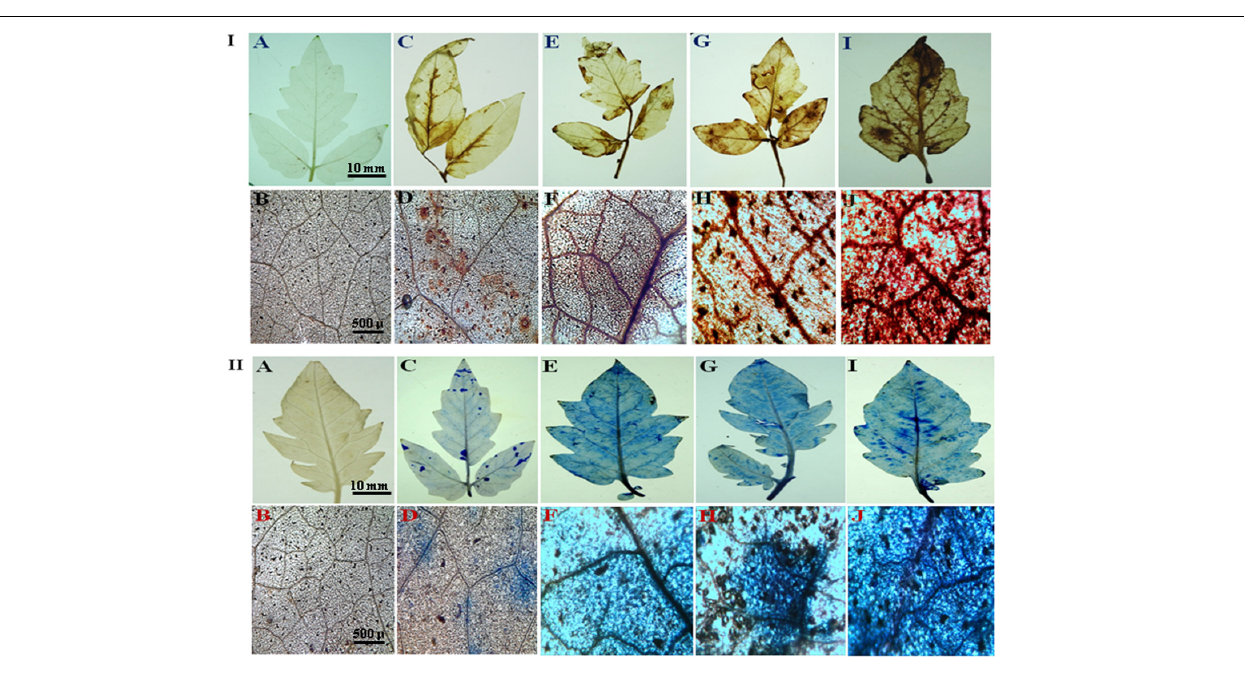
pathogen infection along with their toxins treatment. Significant changes were observed in the toxins treated plants both before and after challenge, but the response was stronger and more visible in the pathogen infected